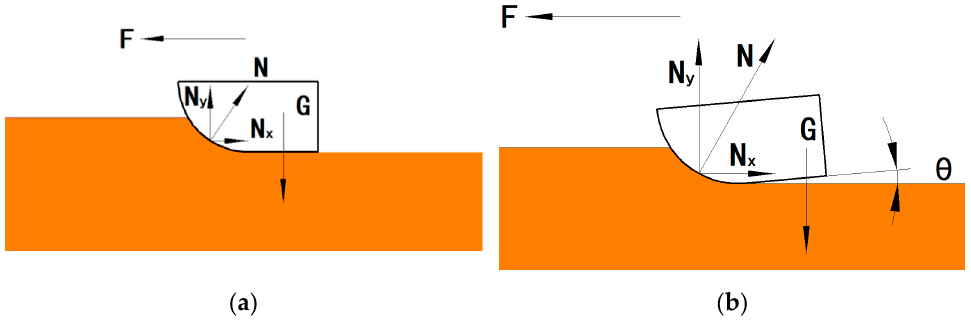
Figure 16. Force analysis of skateboard at different speeds. ( a ) At slow speed; ( b ) at fast speed.